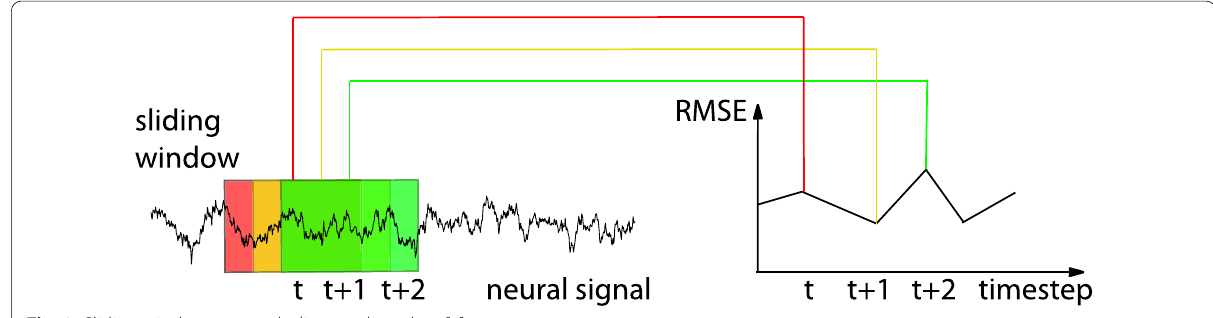
Fig. 2 Sliding window approach diagram, based on